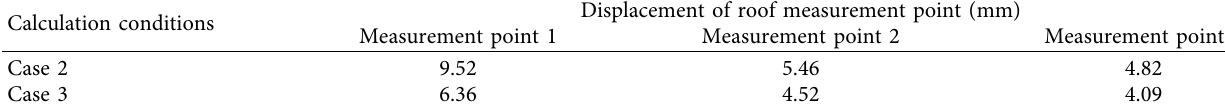
Table 3: Deep displacement of surrounding rock under different